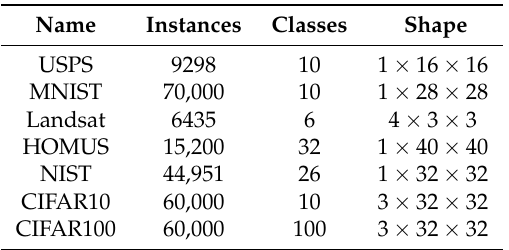
Table 1. Description of the image datasets used in the experimentation. HOMUS, Handwritten Online Musical